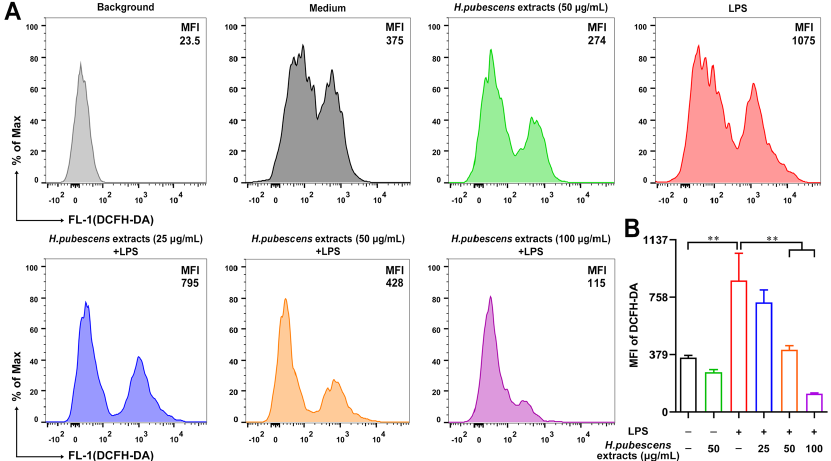
Figure 1. H. pubescens extracts inhibited the ROS level in LPS-irritated DCs. ( A , B ) DCs were cultured with the designed concentrations of H. pubescens extracts or plus LPS (100 ng/mL) for 24 h, and then were collected and incubated with 2 (cid:48) ,7 (cid:48) dichlorofluorescein diacetate (DCFH-DA). ROS production was tested by FCM. All of the data are shown as means ± SD from three experiments. Analysis of variance (ANOVA) was employed. ** p <